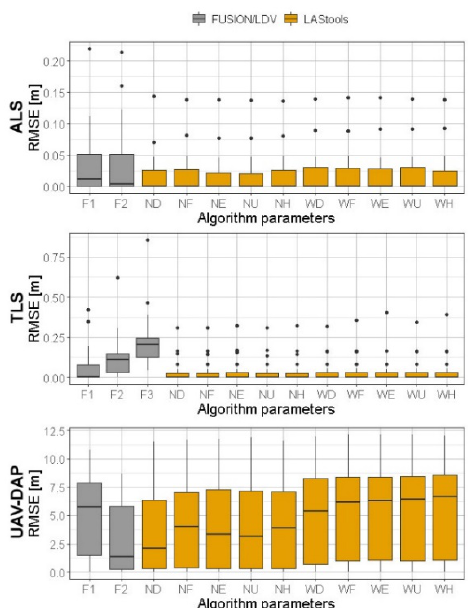
Figure 8. Box and whiskers plot representing the RMSE between the DTMs extracted from the acquisition techniques (i.e., ALS, TLS and UAV-DAP) and the reference DTM, using different processing tools (i.e., FUSION/LDV© and LAStools©) and different algorithm parameters. Abbreviations: F1: g = -1 and w = 1 for ALS and UAV-DAP, and also the focal mean filter and a height tolerance of 0.10 m for TLS; F2: g = -1, w = 1, a focal mean filter and a height tolerance of 0.50 m; F3: g = -1, w = 1, a focal mean filter and a height tolerance of 1 m; N: nature; W: wilderness; D: default: F: fine; E: extrafine; U: ultrafine; H: